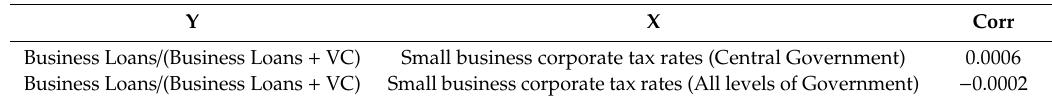
Table 7. Correlation coe ffi cients